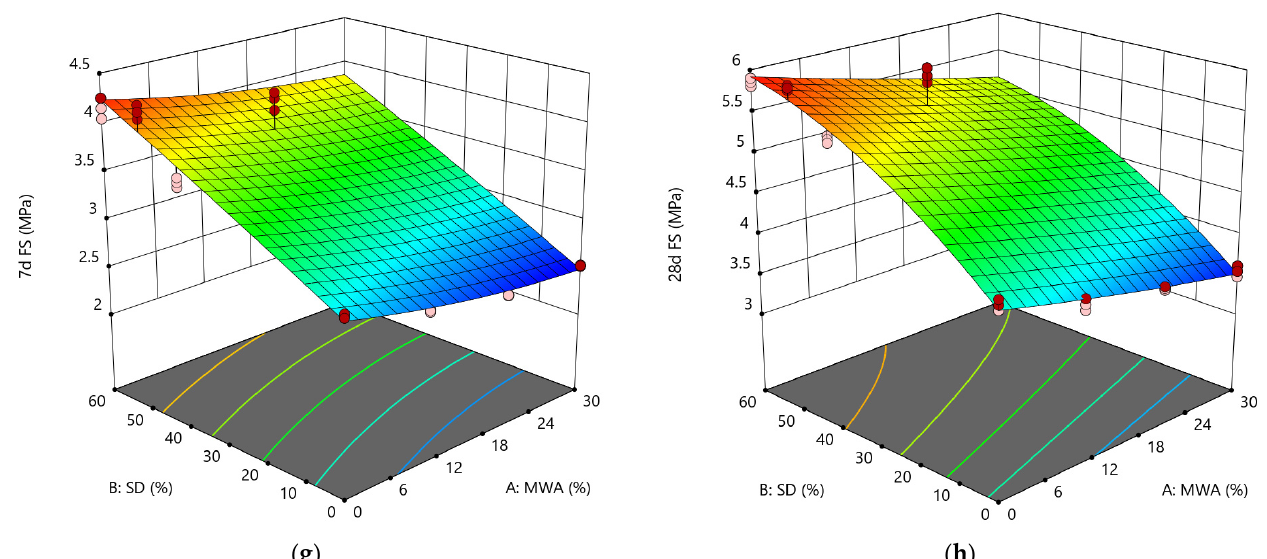
Figure 8. Diagnostic and 3D plots of 7-day and 28-day flexural strength. ( a ) 7-day flexural strength, ( b ) 28-day flexural strength, ( c ) 7-day flexural strength, ( d ) 28-day flexural strength, ( e ) 7-day flexural strength, ( f ) 28-day flexural strength, ( g ) 7-day flexural strength, ( h ) 28-day flexural strength.